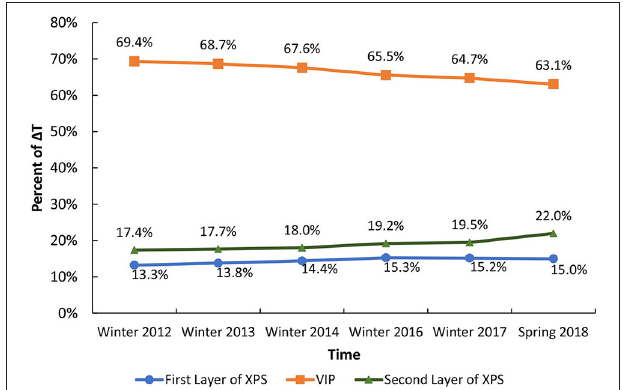
FIGURE 8 | Percentage of temperature drop across wall components, relative to the drop across the entire wall. Data averaged for the winter months 2011–2017 and spring months of 2018.